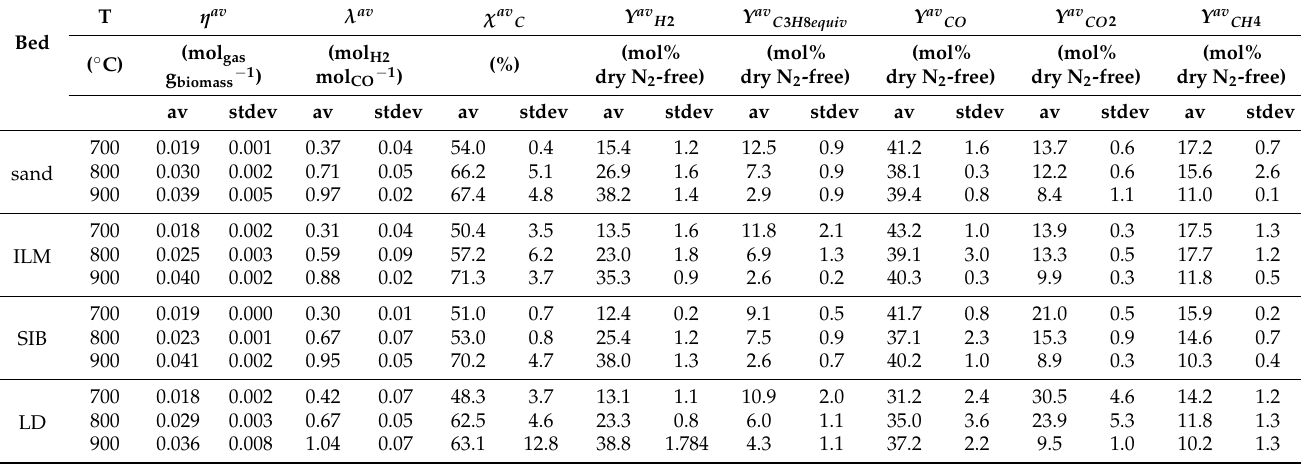
Table A2. Experimental results of RPR devolatilization tests as functions of temperature and kind of bed material (av: average of results from the three individual pellets; stdev: standard deviation of results from the three individual pellets).